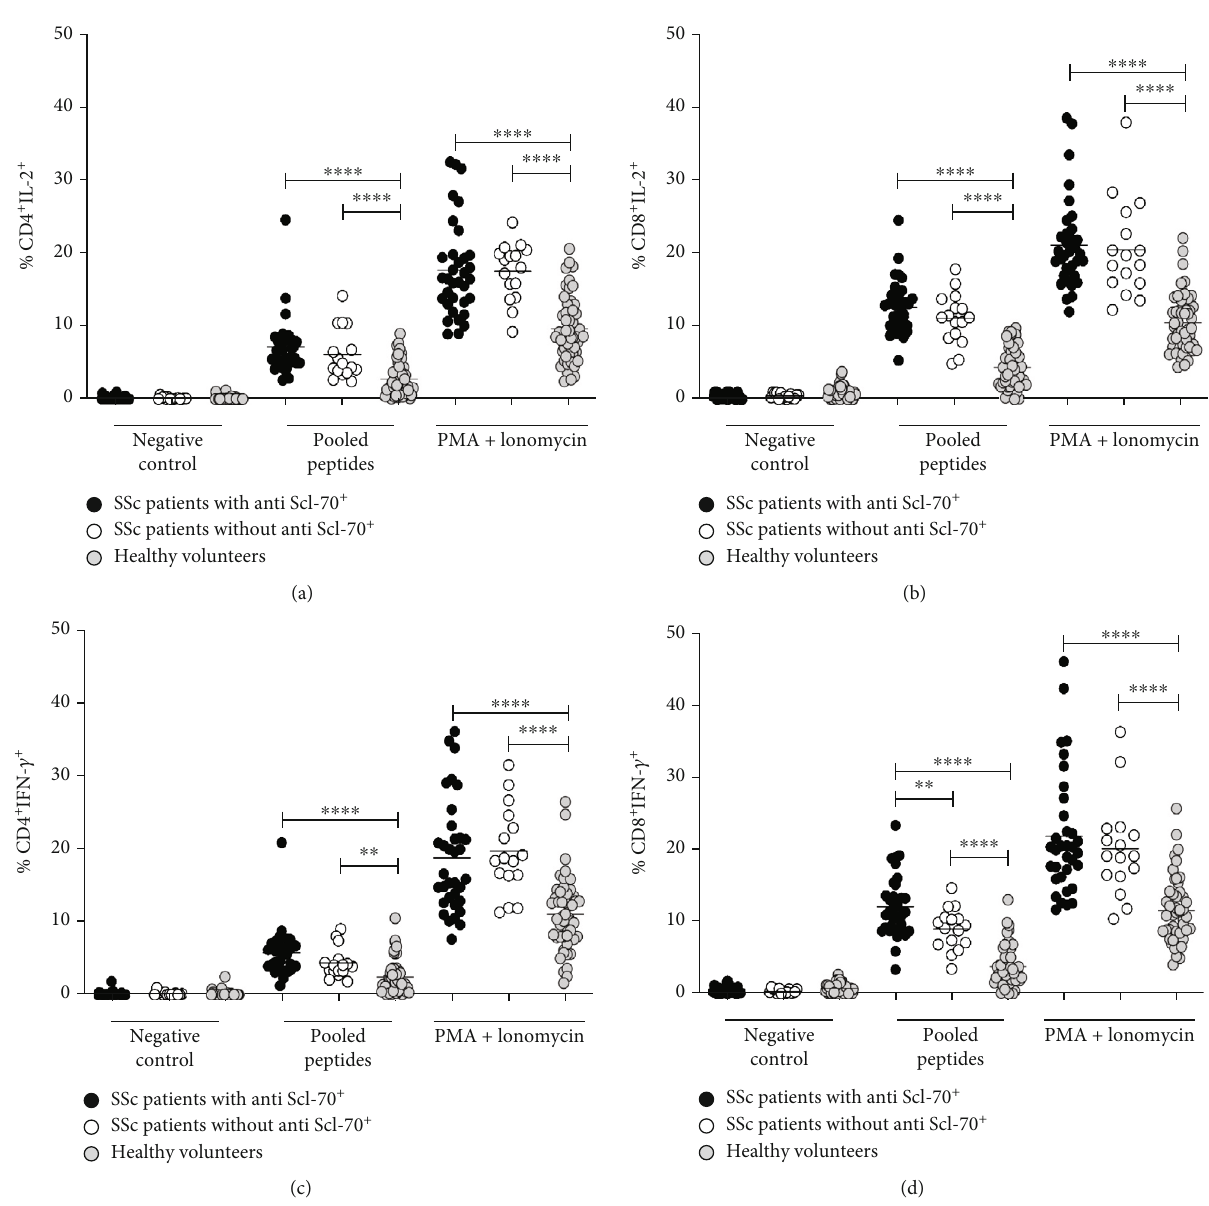
Figure 2: Percentage of cytokine (IFN- γ and IL-2) producing CD4 + (a, c) and CD8 + (b, d) T cells following stimulation with media (negative control), pooled peptides derived from topoisomerase protein, and PMA ionomycin (positive control) in SSc patients with positive anti-Scl70 antibodies ( n = 34 ) and SSc patients with negative anti-Scl70 antibodies ( n = 16 ) (Student ’ s t -test, ∗∗∗∗ p value < 0.001, ∗∗ p value <